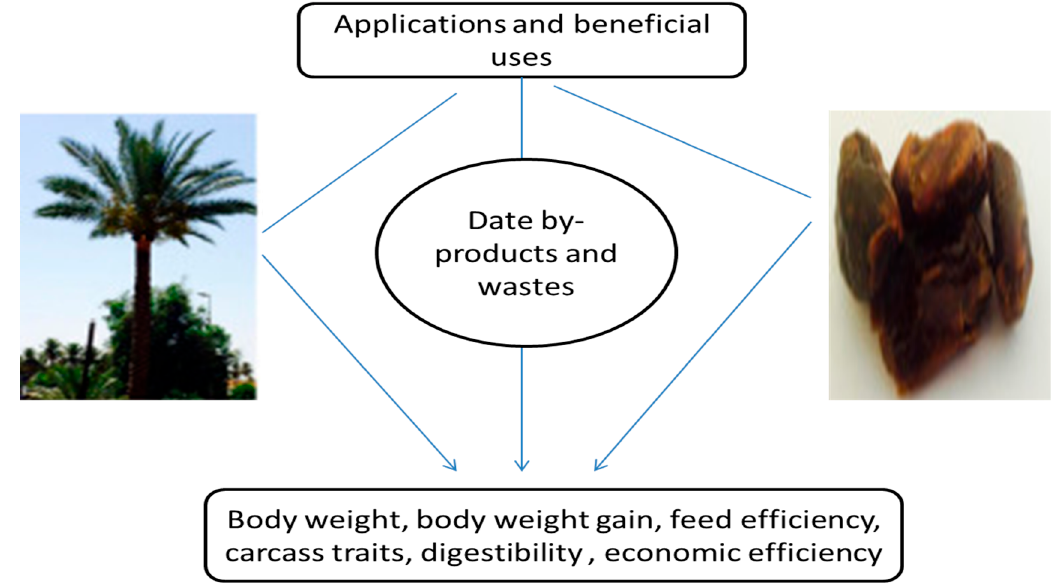
Figure 1. Application and beneficial uses of date by-products and wastes in poultry nutrition.